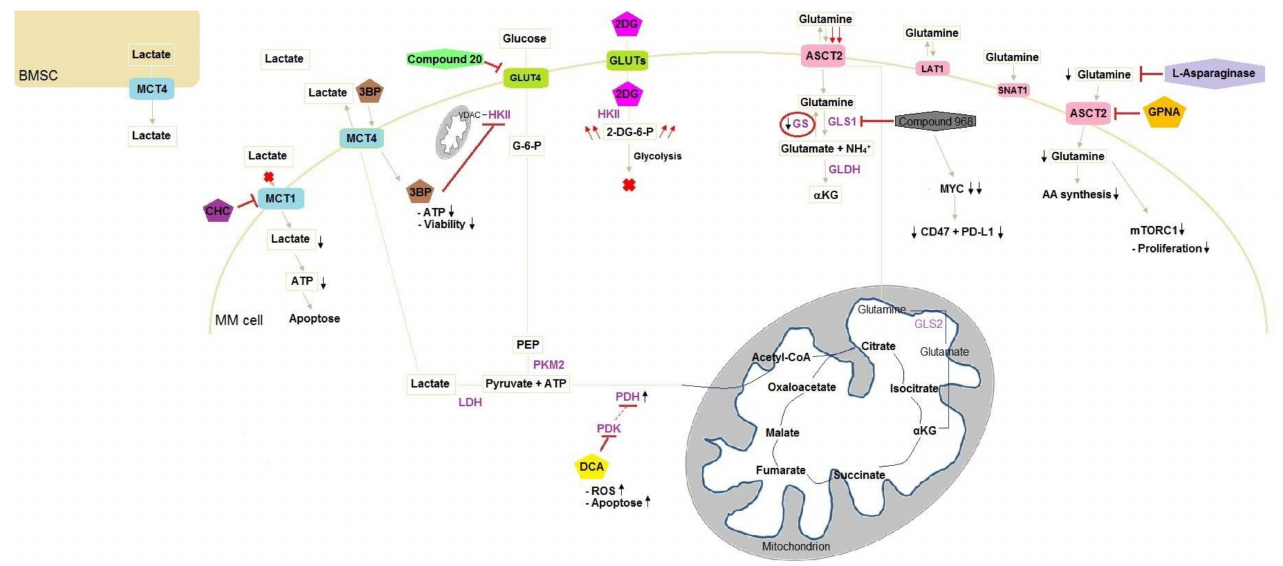
Figure 1. Schematic presentation of targets in glucose and glutamine metabolism in MM cells. Metabolic rearrangements in MM cells after administering compounds inducing stimulation or inhibition. 3BP enters the cell through MCT4 and inhibits HKII connected to the outer mitochondrial membrane via VDAC leading to ATP reduction and the loss of viable cells. 2DG enters the cell through GLUT and is phosphorylated by HKII. The phosphorylated form cannot be metabolised and accumulates by consequence leading to glycolysis blockage. Compound 20 inhibits GLUT4 resulting in chemosensitising. The inhibition of PDK on PDH is suppressed after addition of DCA to MM cells, which inhibits PDK. As a result, PDH activity increases and lactate production decreases, whereby TCA activity is increased. CHC is a MCT1 competitive inhibitor and blocks the entrance of lactate into the cell. This lack of fuel results in apoptosis due to ATP reduction. However, BMSC supply MM cells with lactate. Glutamine enters the cell through three transporters: ASCT2, LAT1 and SNAT1, with ASCT2 being the major glutamine transporter. Compound 968 inhibits GLS inducing MYC degradation and decrease of CD47 and PD-L1. MM cells lack GS, resulting in low intracellular glutamine concentrations and leading to higher glutamine influx. GPNA is a glutamine transporter inhibitor and induces a lack of glutamine intracellularly, which disadvantages AA synthesis and reduces mTORC1 activity, resulting in less cell proliferation. Instead of inhibiting glutamine transporters, L -asparaginase hydrolyses glutamine. AA, amino acid; BMSC, bone marrow stromal cells; 3BP, 3-bromopyruvate; CHC, α -cyano-4-hydroxycinnamic acid; DCA, dichloroacetate; 2DG, 2-deoxyglucose; 2-DG-6-P, 2-deoxyglucose-6-phosphate; G-6-P, glucose-6-phosphate; GLDH, glutamate dehydrogenase; GLS1, glutaminase 1; GLS2, glutaminase 2; GPNA, l- γ -glutamyl-p-nitroanilide; GS, glutamine synthetase; HKII, hexokinase II; LDH, lactate dehydrogenase; MM, multiple myeloma; MYC, myelocytomatosis oncogene cellular homolog; PDH, pyruvate dehydrogenase; PDK, pyruvate dehydrogenase kinase; PEP, phosphoenolpyruvate; PKM2, pyruvate kinase M2; ROS, reactive oxygen species; VDAC, voltage-dependent anion channel; , reduction; , strong reduction; , increase; , strong